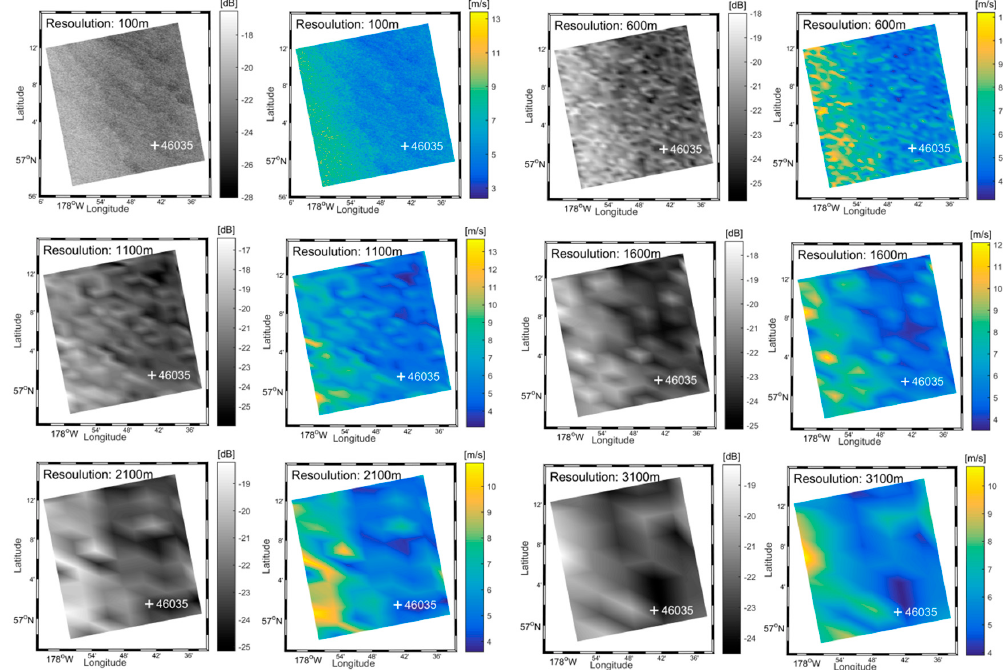
Figure 15. VV-polarized SAR images at reconstructed spatial resolutions of 100, 600, 1100, 1600, 2100 and 3100 m and corresponding OSWSs retrieved from the C2PO model. The in-situ buoy (#46035, 57°1 ′ 33 ″ N 177°44 ′ 16 ″ W) wind speed is 2.92 m/s. RADARSAT-2 Data and Product MacDonald, Detteiler and Associates Ltd., All Rights Reserved.